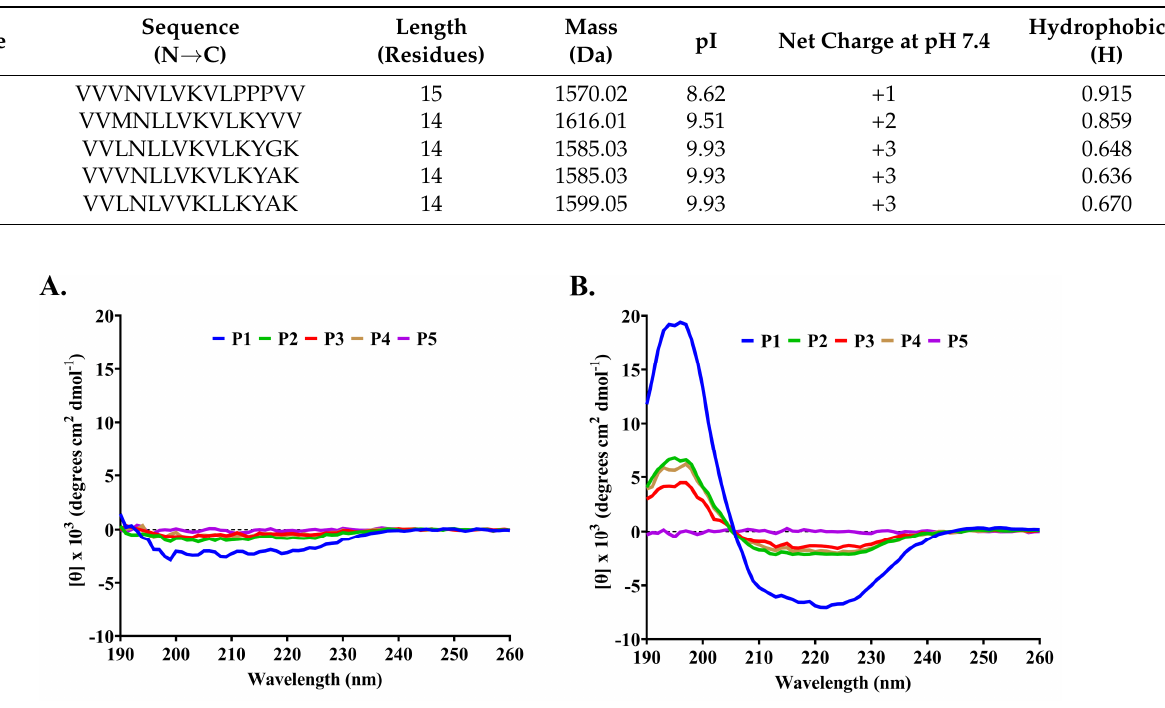
Figure 3. CD spectra of anti-MRSA peptides (P1–P5) from SPR-20. The peptide samples (0.6 mg/mL) were prepared in ( A ) deionized water and ( B ) 50 mM SDS. The CD spectra were measured at 25 °C in the wavelength between 190 and 260 nm. Table 4. Estimation of secondary structure content of anti-MRSA peptides. The peptides were dis- solved in the different solvents (deionized water and 50 mM SDS), and the predicted secondary structures were analyzed by the CONTINLL program.